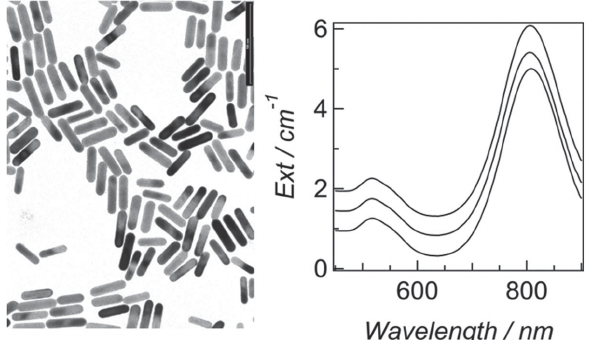
Figure 2. Representative TEM of synthesized gold nanorods. And optical extinction spectra of cetrimonium-terminated 15 , CAI- and 2-methoxyethylamine conjugated particles 16 and 17 in aqueous suspensions, respectively, from bottom to top [21].